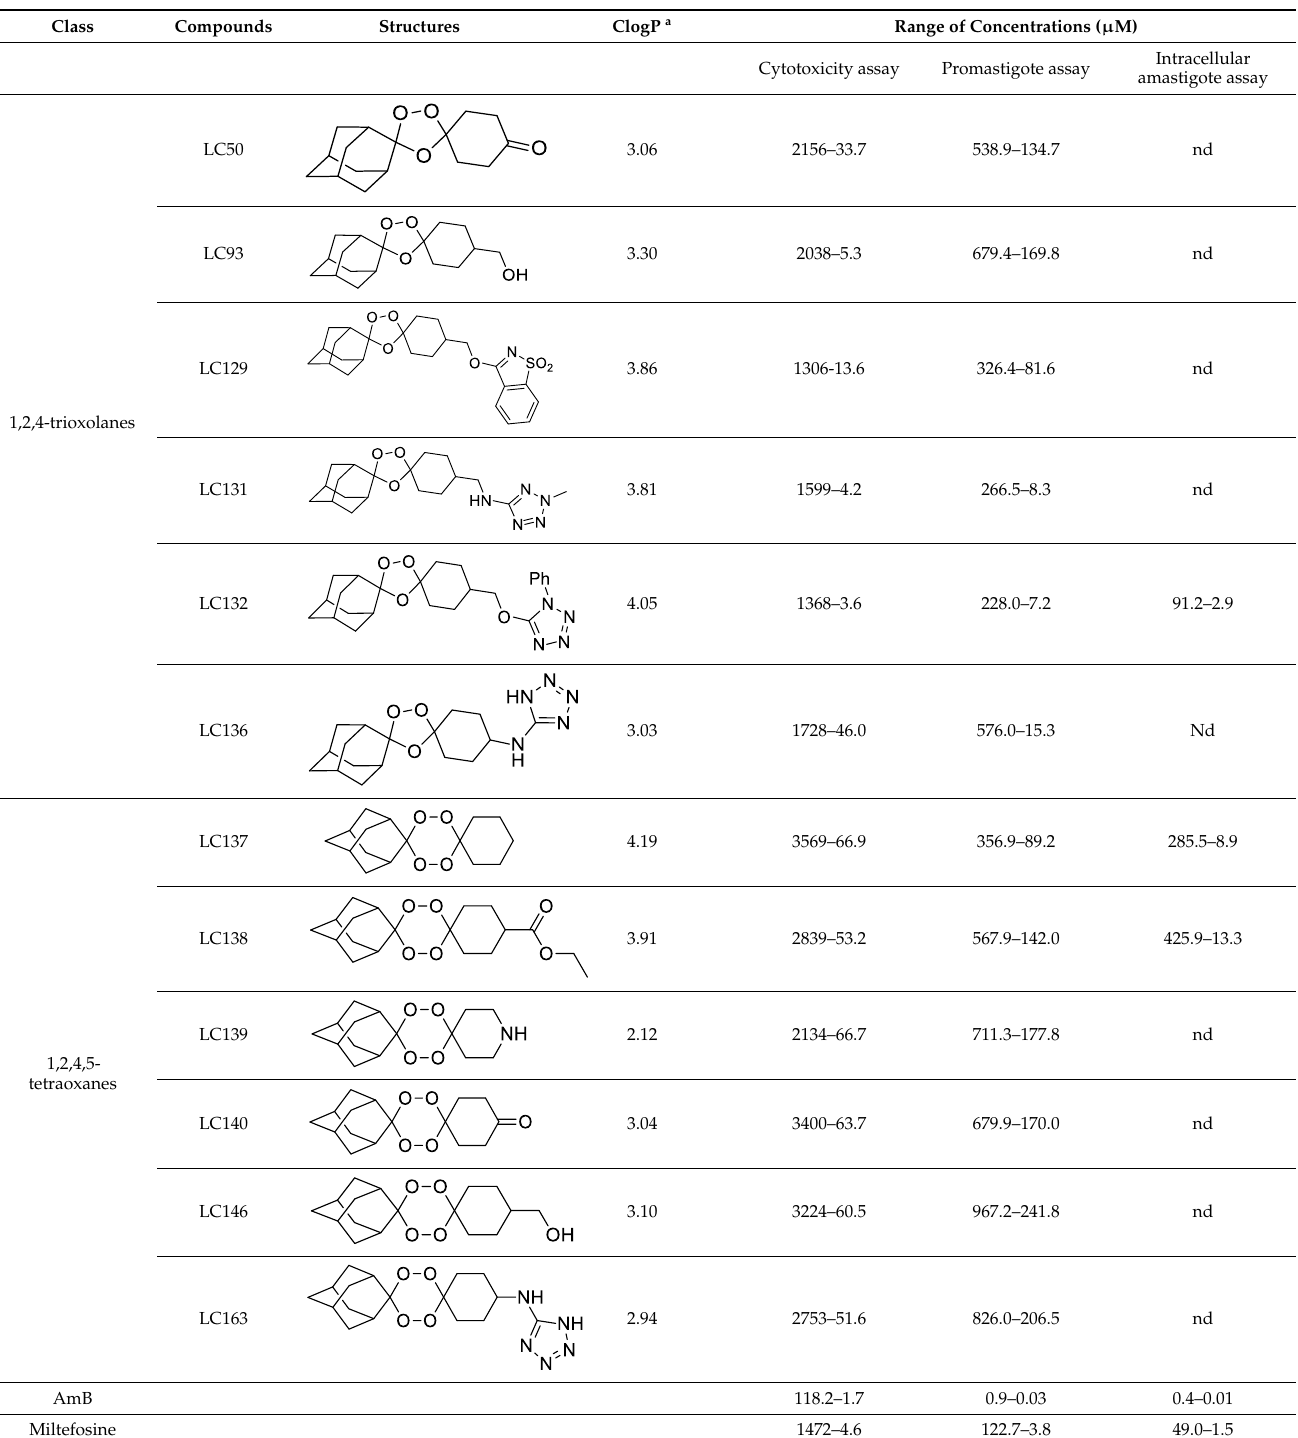
Table 3. Structures of 1,2,4-trioxolanes and 1,2,4,5-tetraoxanes synthesized and concentration ranges